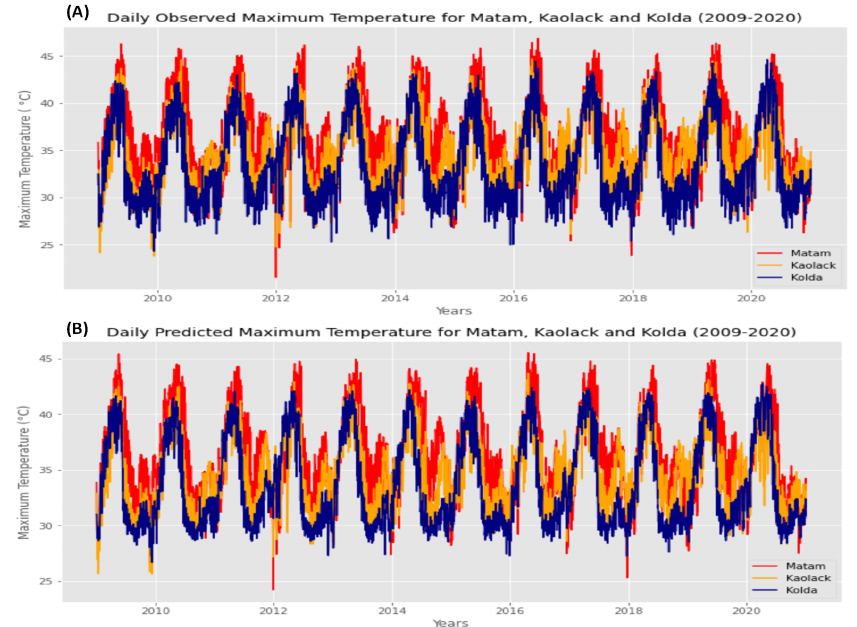
Figure 21. Observed and Forecasted Maximum Temperature for Matam, Kaolack and Kolda